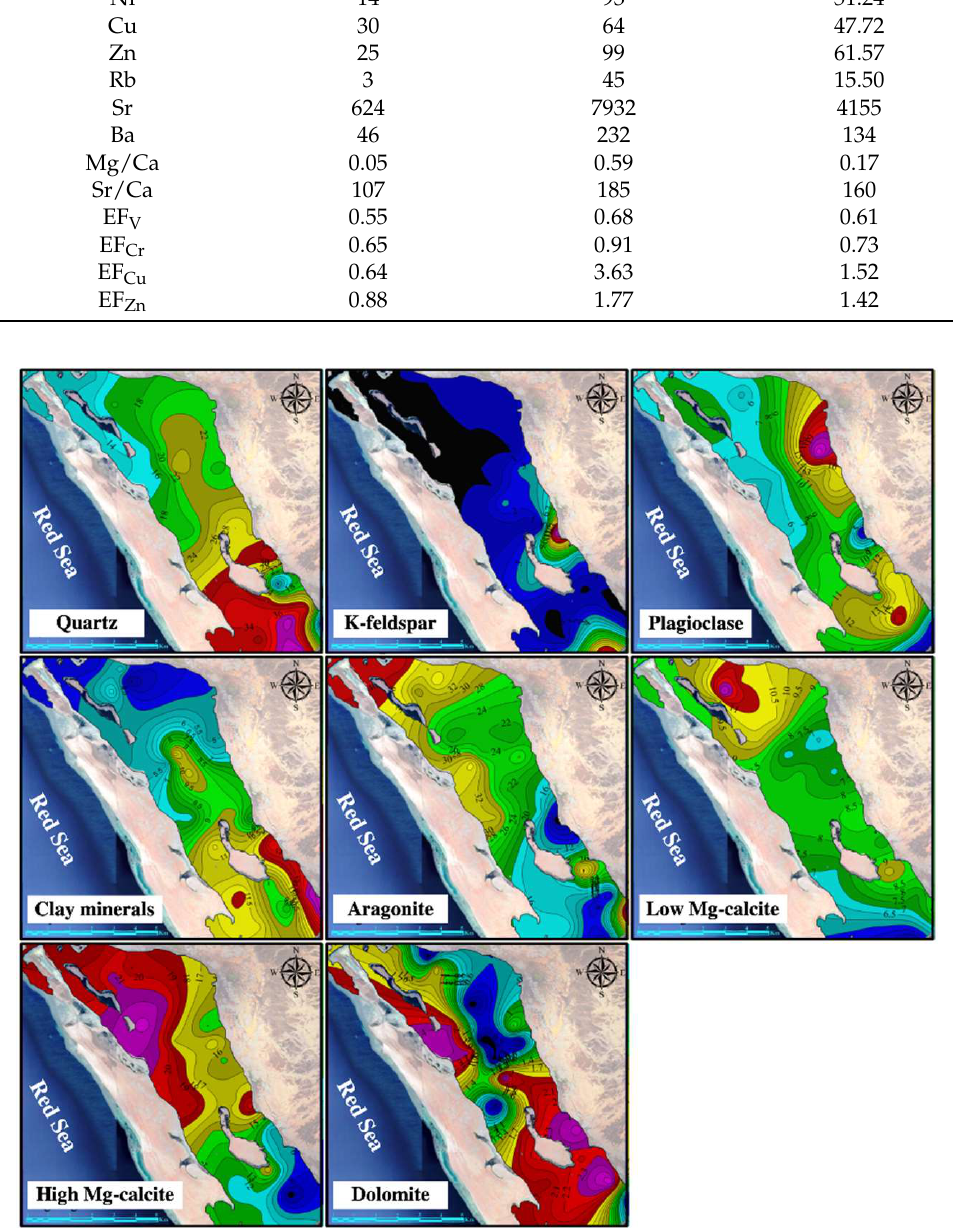
Figure 2. Contour maps showing the spatial distribution of the most common minerals in the bottom sediments of the Sharm Al-Kharrar. Light blue scale bar on maps equals 6 km.